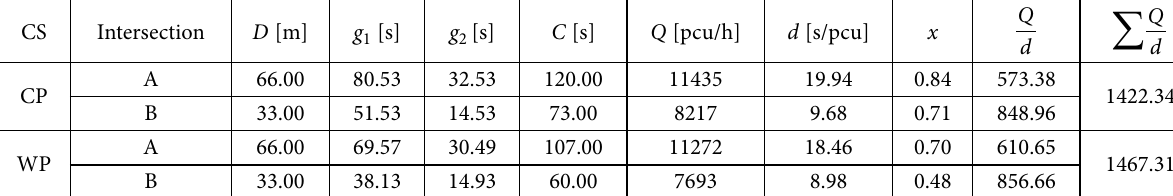
Table 2. Involved parameters and performance indices for the existing (CP) and Webster’s (WP)